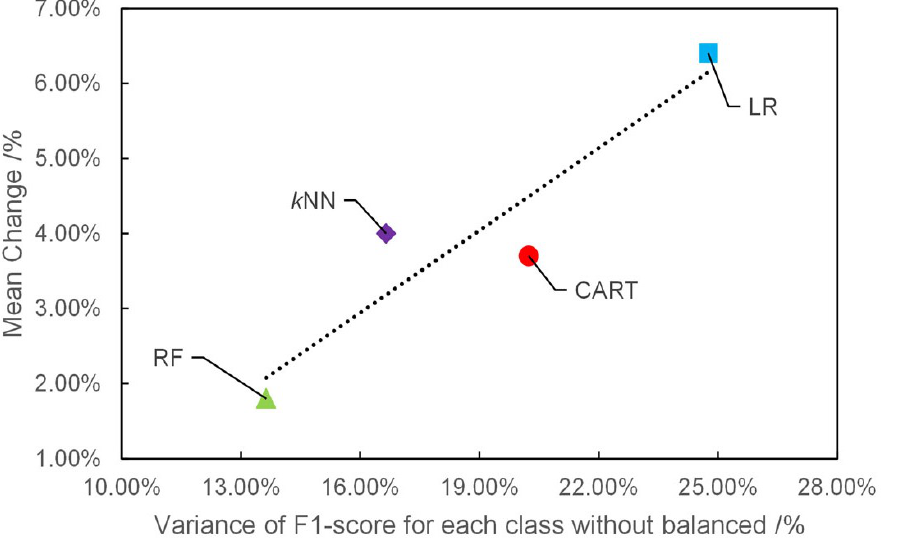
Figure 4. Mean change in overall accuracy from baseline (unbalanced dataset) to balanced dataset after processing in the sub-training set T2 . The dashed line shows a linear correlation between mean change and variance of F1-score for each class without